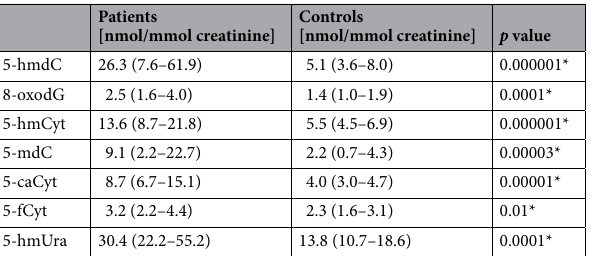
(Table S1). The ALL patients were divided based on disease subtype (B and T type), and all the analyzed parameters in urine were determined separately by subtype (Table S2 in Supplementary Materials). ETV6/RUNX1 gene fusion generated by t(12;21)(p13;q22) is the most common chromosomal abnormality in children with B-ALL 15–17 . The differences were significant for 5-hmdC, 5-hmCyt, 5-fCyt and 5-hmUra (Table S3 in Supplementary Materials). Notably, after the completion of chemotherapy, the exceedingly high values dropped to levels observed in the